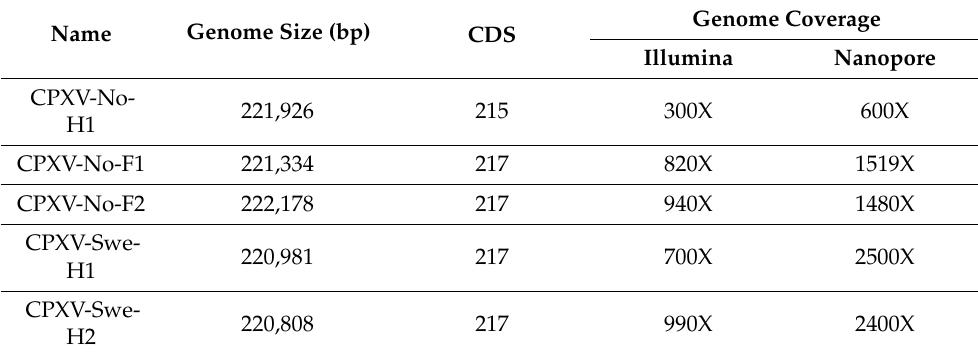
Table 1. Genome size, number of predicted coding sequences (CDS) and genome coverage of the Fennoscandian CPXV isolates sequenced in this study. Name Genome Size (bp) CDS